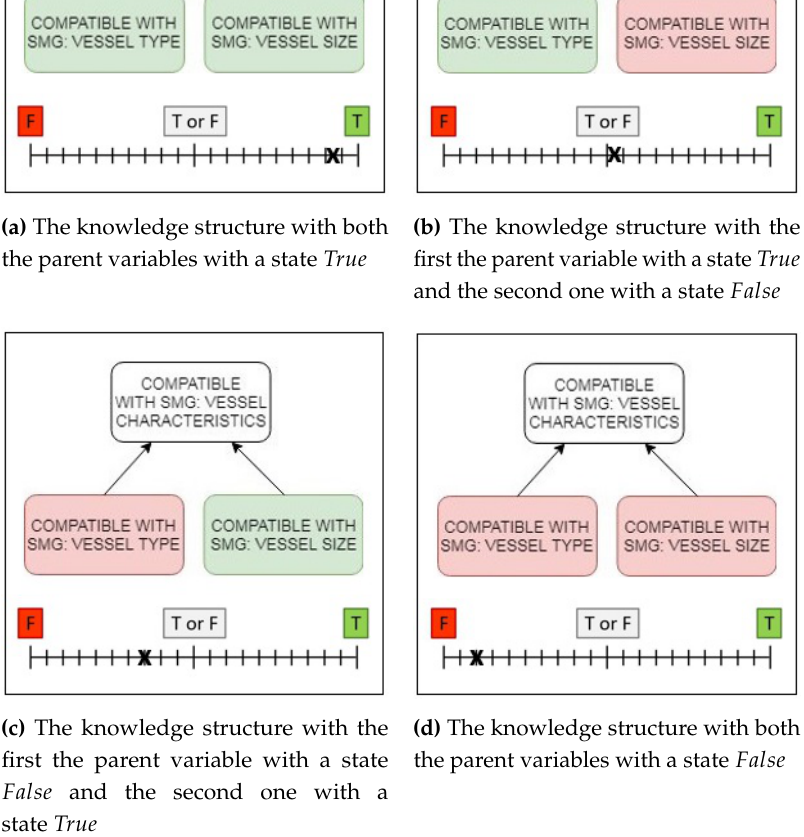
Figure 8. Examples of different configurations of the same knowledge structure.